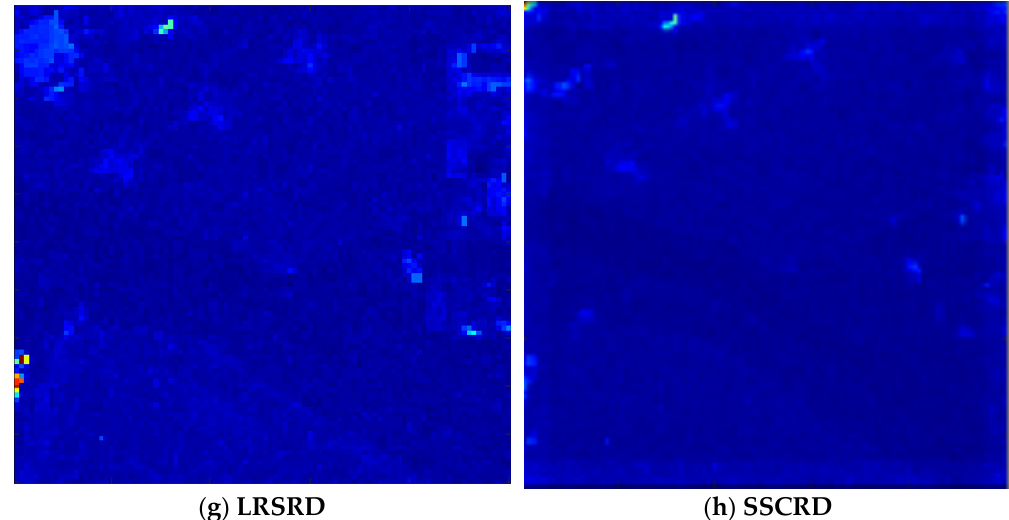
Figure 2. Color detection maps for San Diego-I image with dual-window sizes (7,11). ( a ) False color image; ( b ) ground-truth map; ( c ) over-segmentation; ( d ) label map P; ( e ) the detection result of CRD; ( f ) the detection result of CRBORAD; ( g ) the detection result of LRSRD; ( h ) the detection result of SSCRD.